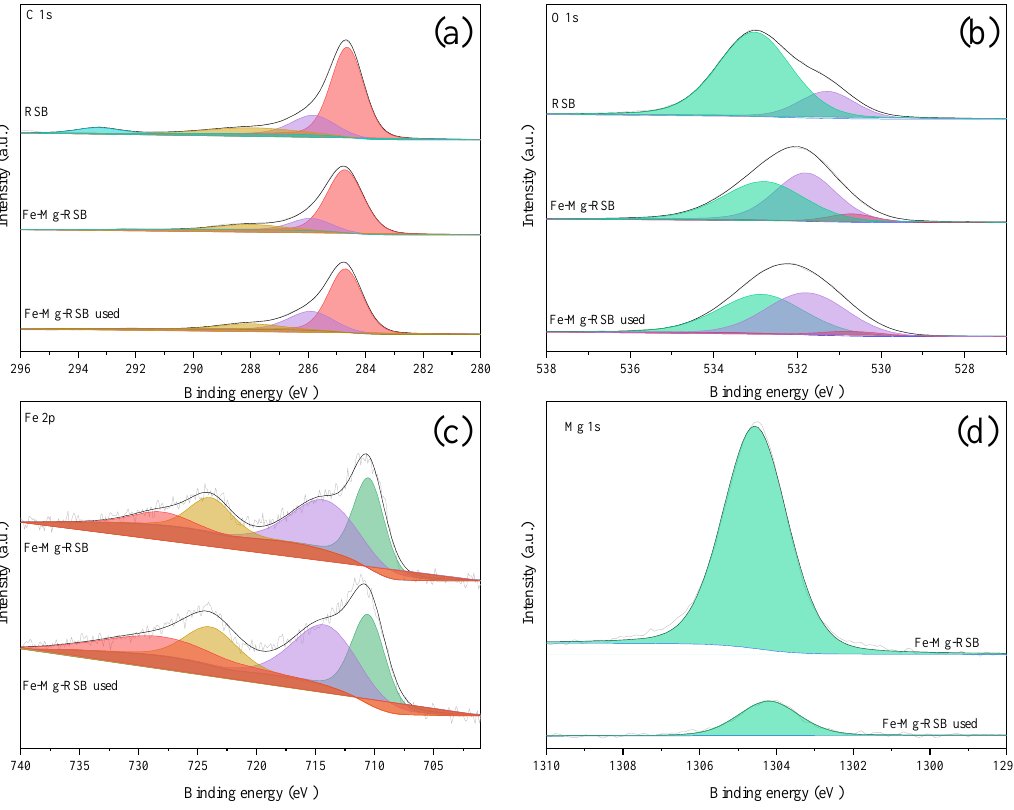
Figure 3. C 1s XPS spectra ( a ). O 1s XPS spectra ( b ). Fe 2p XPS spectra ( c ) and Mg 1s XPS spectra ( d ) of biochars.